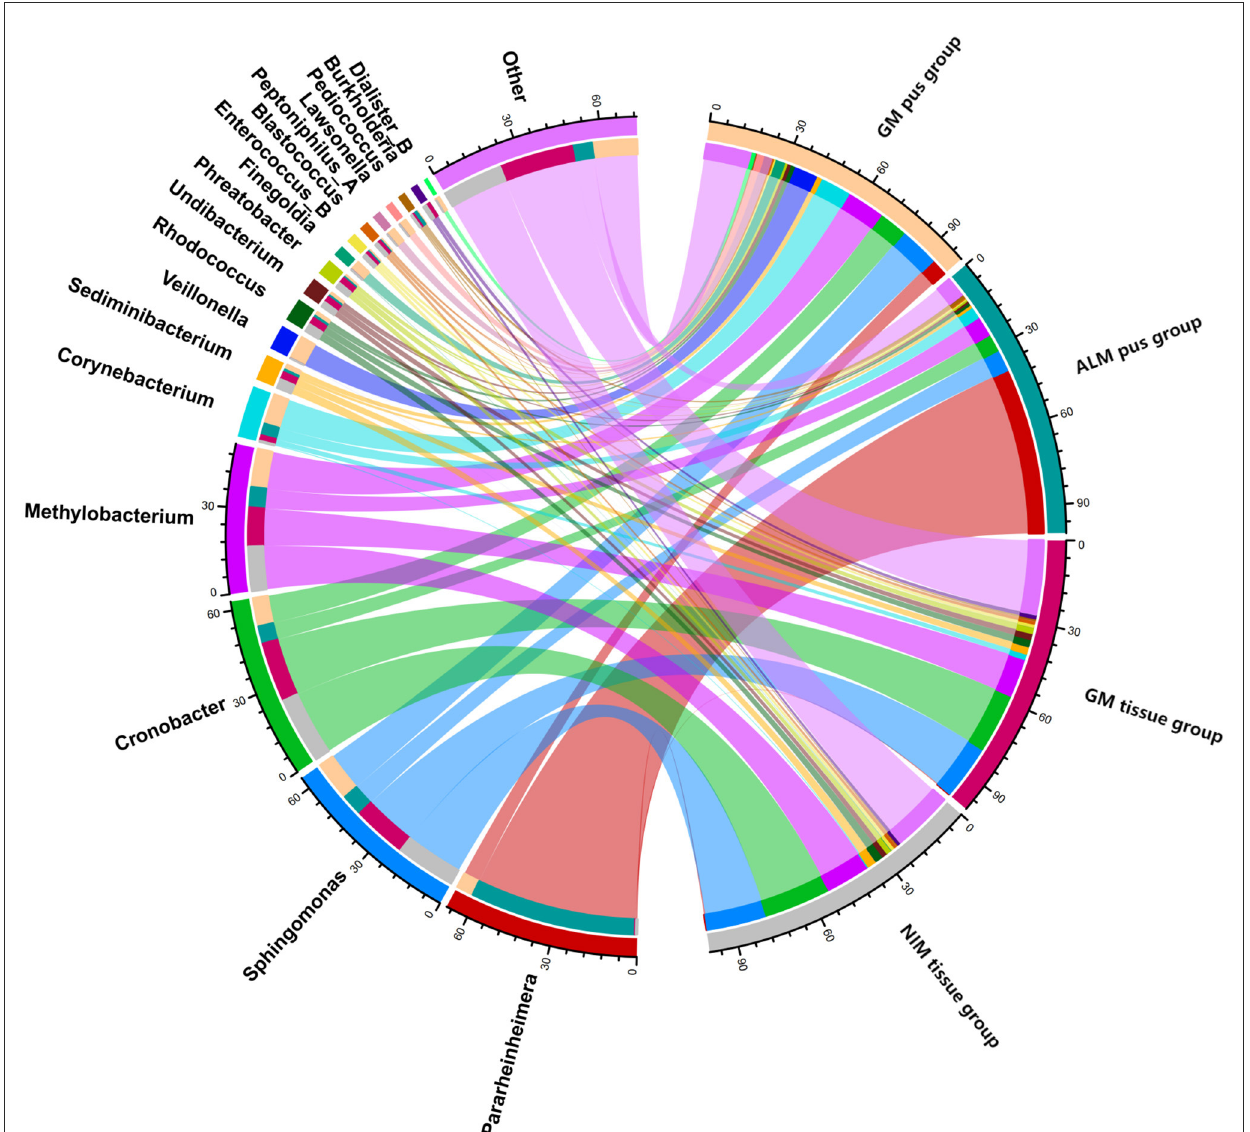
FIGURE4 Collinearity relationship plot. The right semicircle indicates the genera abundance composition of the groups, while the left semicircle shows the proportion of genera in different groups. The number at the edge of the circle represents the genera abundance of the right semicircle and the proportion of genera on the left